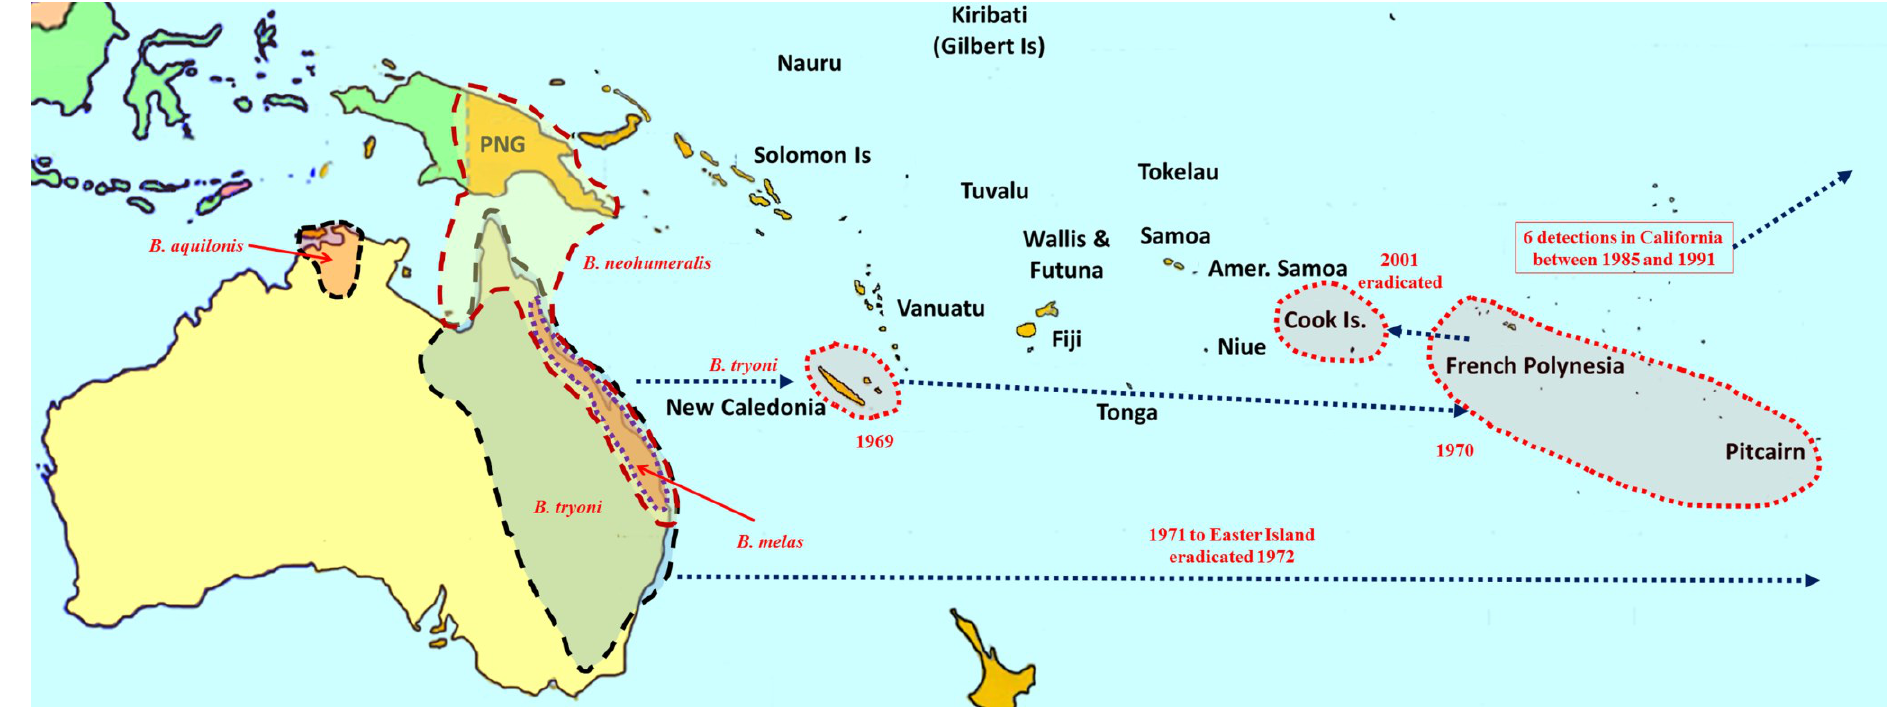
Figure 3. Distribution and invasion history of species in the Queensland fruit fly ( Bactrocera tryoni )